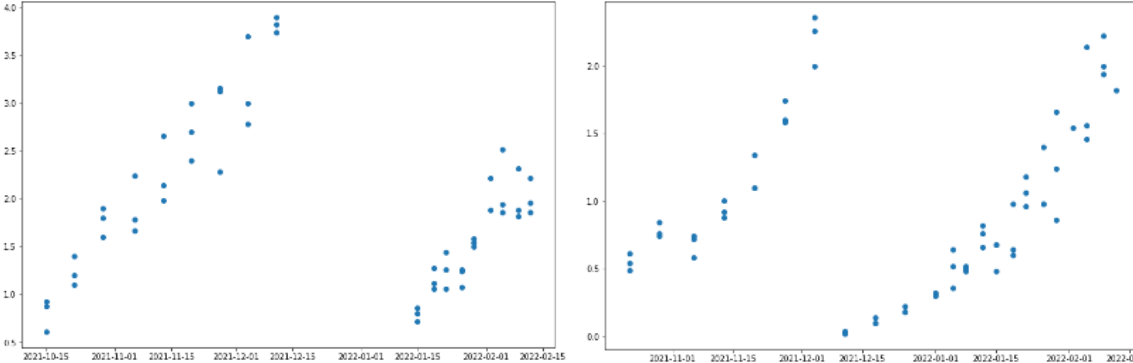
Figure 4 . Broiler growth estimate in two separate barns for two production cycles (horizontal axis – date of measurement taken, vertical axis – broiler weight in kg)